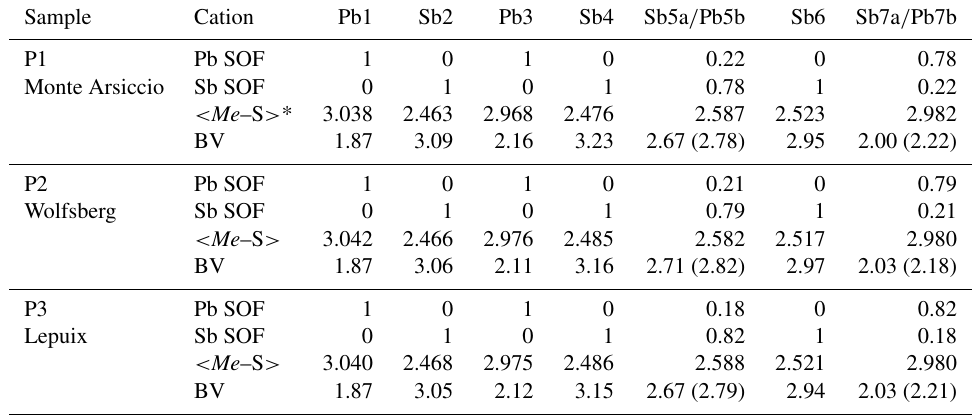
Table 4. Pb-versus-Sb distribution (SOF), average bond distances < Me –S > , and cation bond valences (BVs) in the studied samples of plagionite.